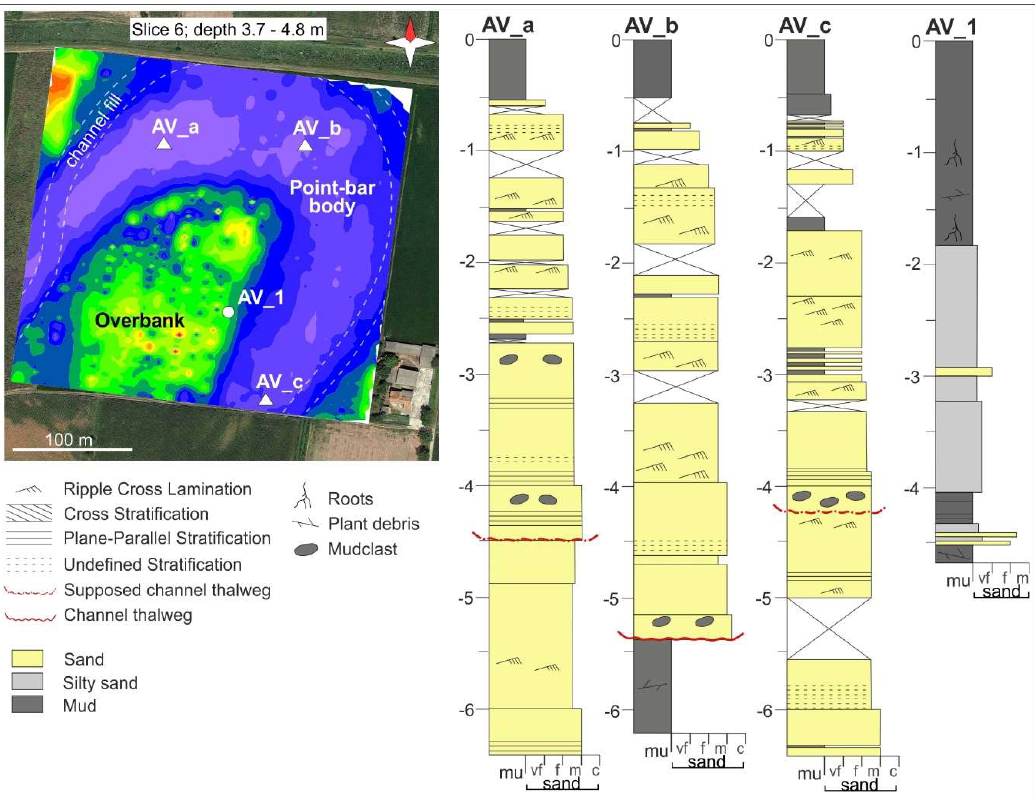
Figure 10. Volume of the point-bar body ( a ) reconstructed through the present study and ( b ) inferred assuming bar growth from a straight channel, as suggested by classical sedimentological models.